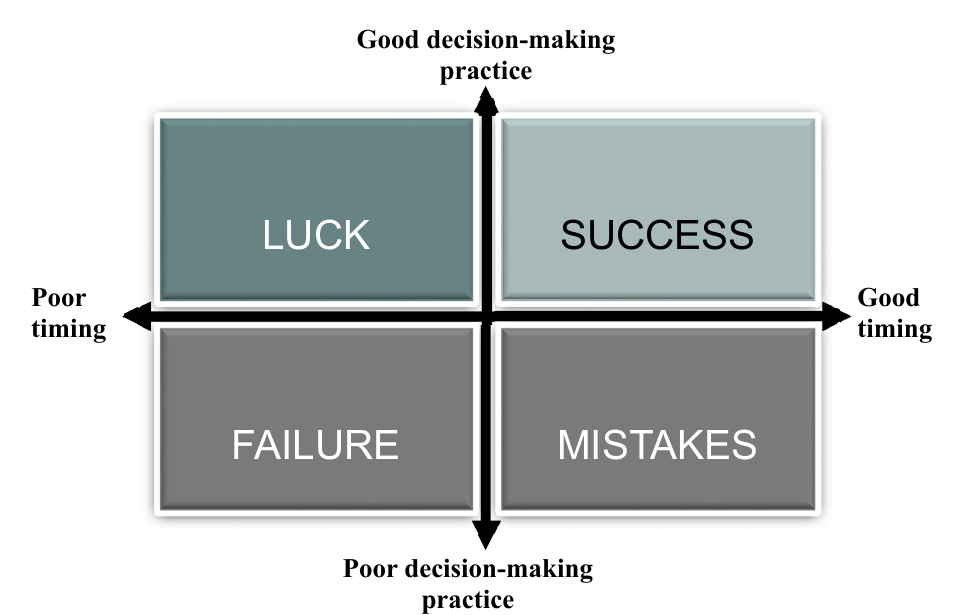
Figure 1. Possible end results of a decision in view of timing of the decision and thoroughness of the decision process.